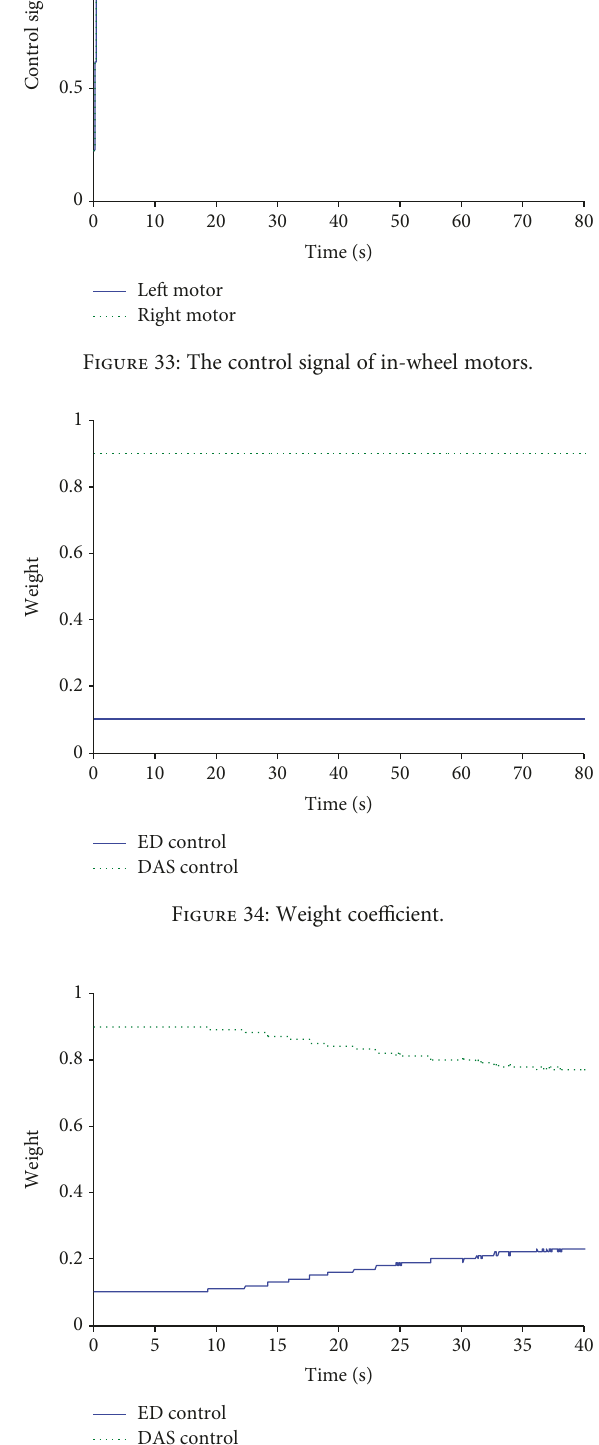
Figure 35: Weight coe ffi